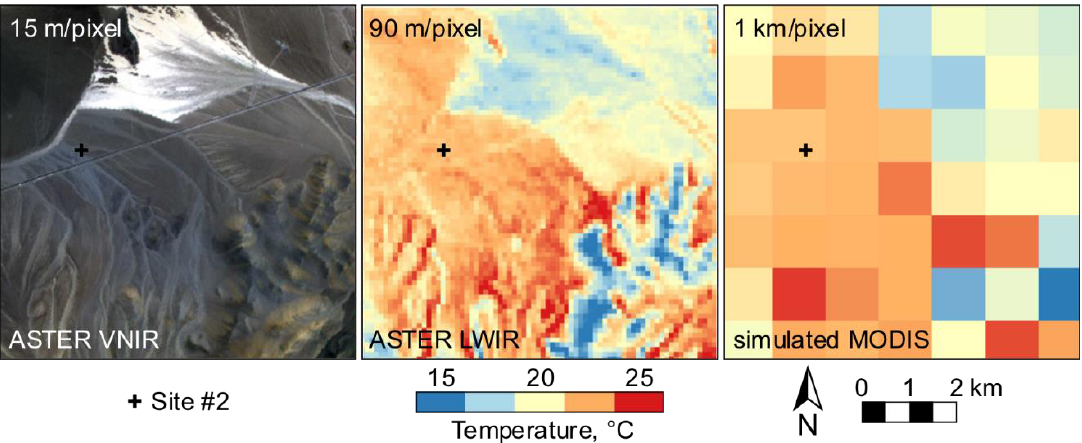
Figure 11. Effect of resolution. The heterogeneity in topographic and geologic features visible from an ASTER 15-m VNIR image (left, AST_L1B_00304082017144319 (11:43 AM local): RGB = band 3 (0.81 µ m), band 2 (0.66 µ m), band 1 (0.56 µ m)) are resolved less well in an ASTER 90-m Surface Kinetic Temperature product (middle, AST_08_00304082017144319) produced from TIR bands (RGB = band